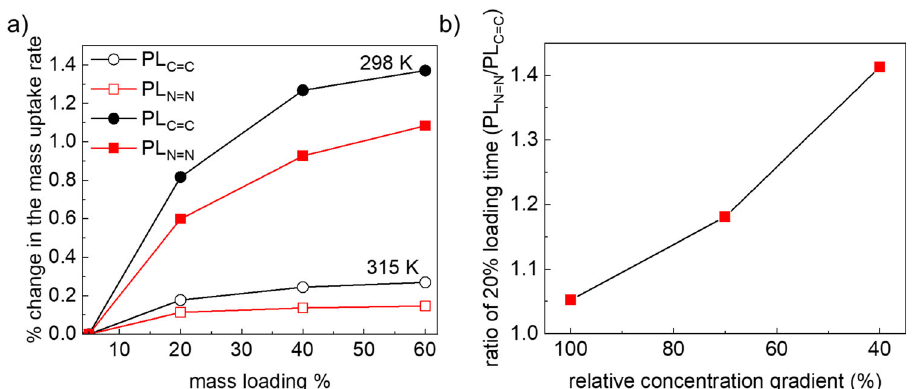
similar; chemical structure of the different pillars are shown in the inset, b Arrhenius plot of diffusivity and c equilibrium constant. Error bars calculated using fi tting parameters.